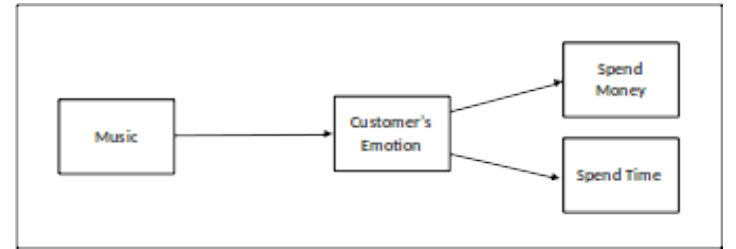
Figure 1: Theoretical Framework of the